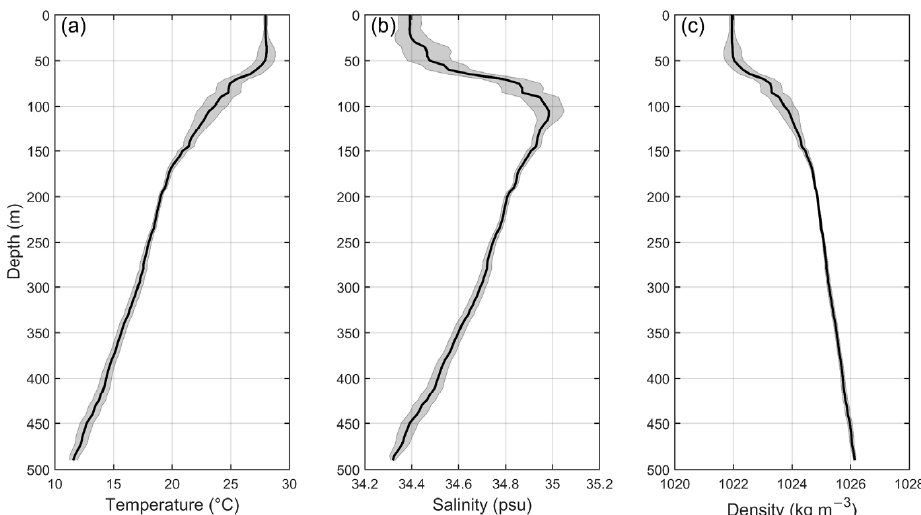
Figure 8. Initial temperature, salinity, and density profiles as the initial conditions of the three-dimensional Price–Weller–Pinkel (3DPWP) model. ( a ) Temperature profile; ( b ) salinity profile; and ( c ) density profile. The thick black lines represent the average of the Argo temperature, salinity, and density profiles on 7–9 October. The shadings represent the error bars of the 95% confidence inter- vals.